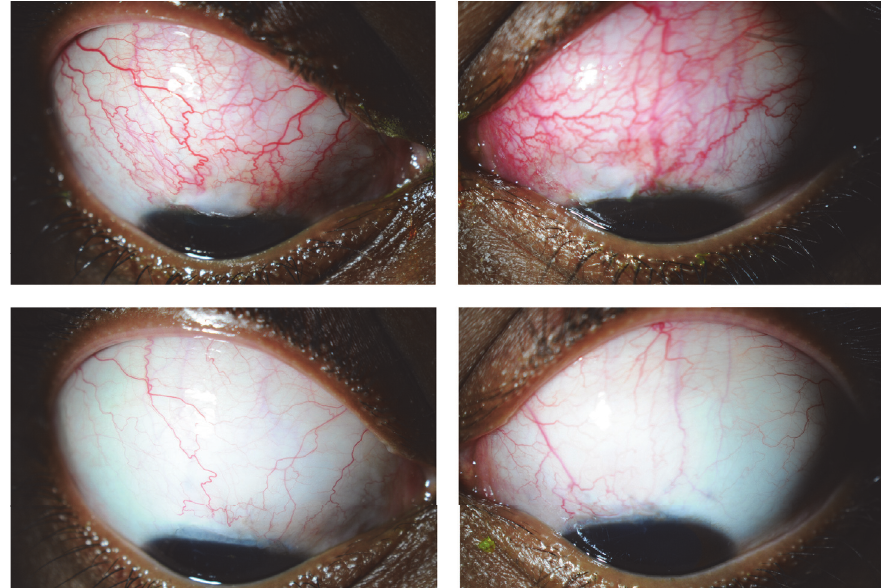
Figure 1: Anterior segment photographs showing the evolution of trabeculectomy blebs: one month (top panels) and four months post-op (bottom